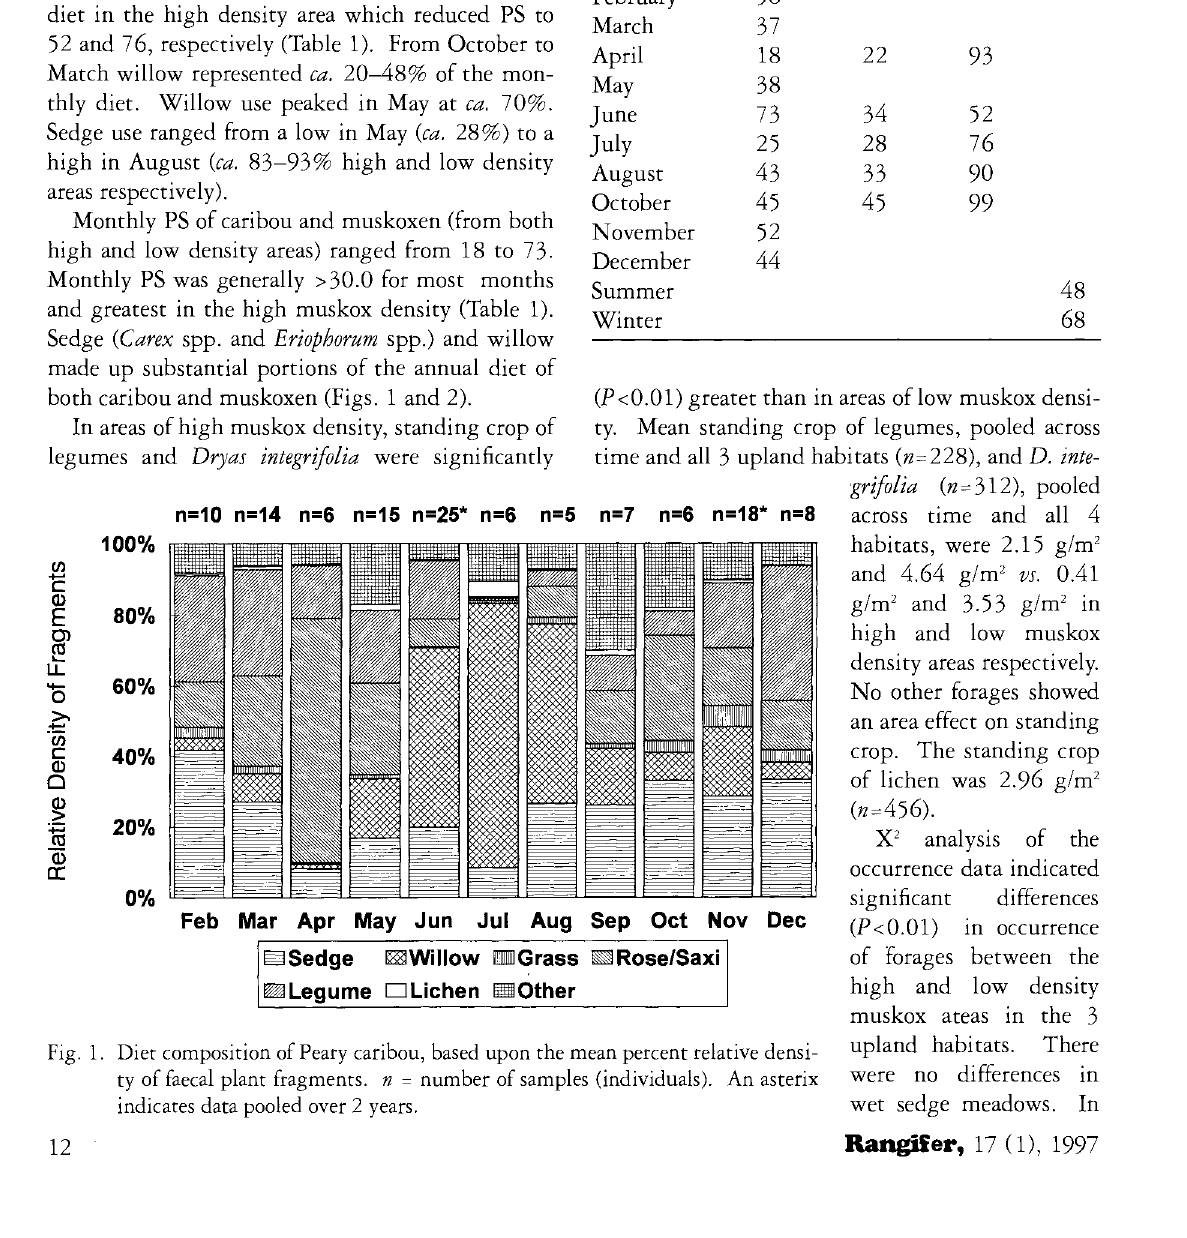
Diet composition of Peary caribou, based upon the mean percent relative densi ty of faecal plant fragments, n = number of samples (individuals). An asterix indicates data pooled over 2 years.